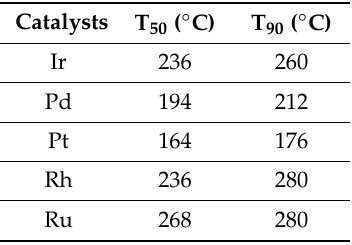
Figure 5. Light-off curves of CO conversion for the different materials. Feedstream composition: 0.02% NO, 0.5% CO, 10% O 2 and 20% CO 2 , and balance He. Space velocity: 2.24 10 4 h − 1. Table 4. T 50 and T 90 of catalysts’ catalytic CO oxidation.